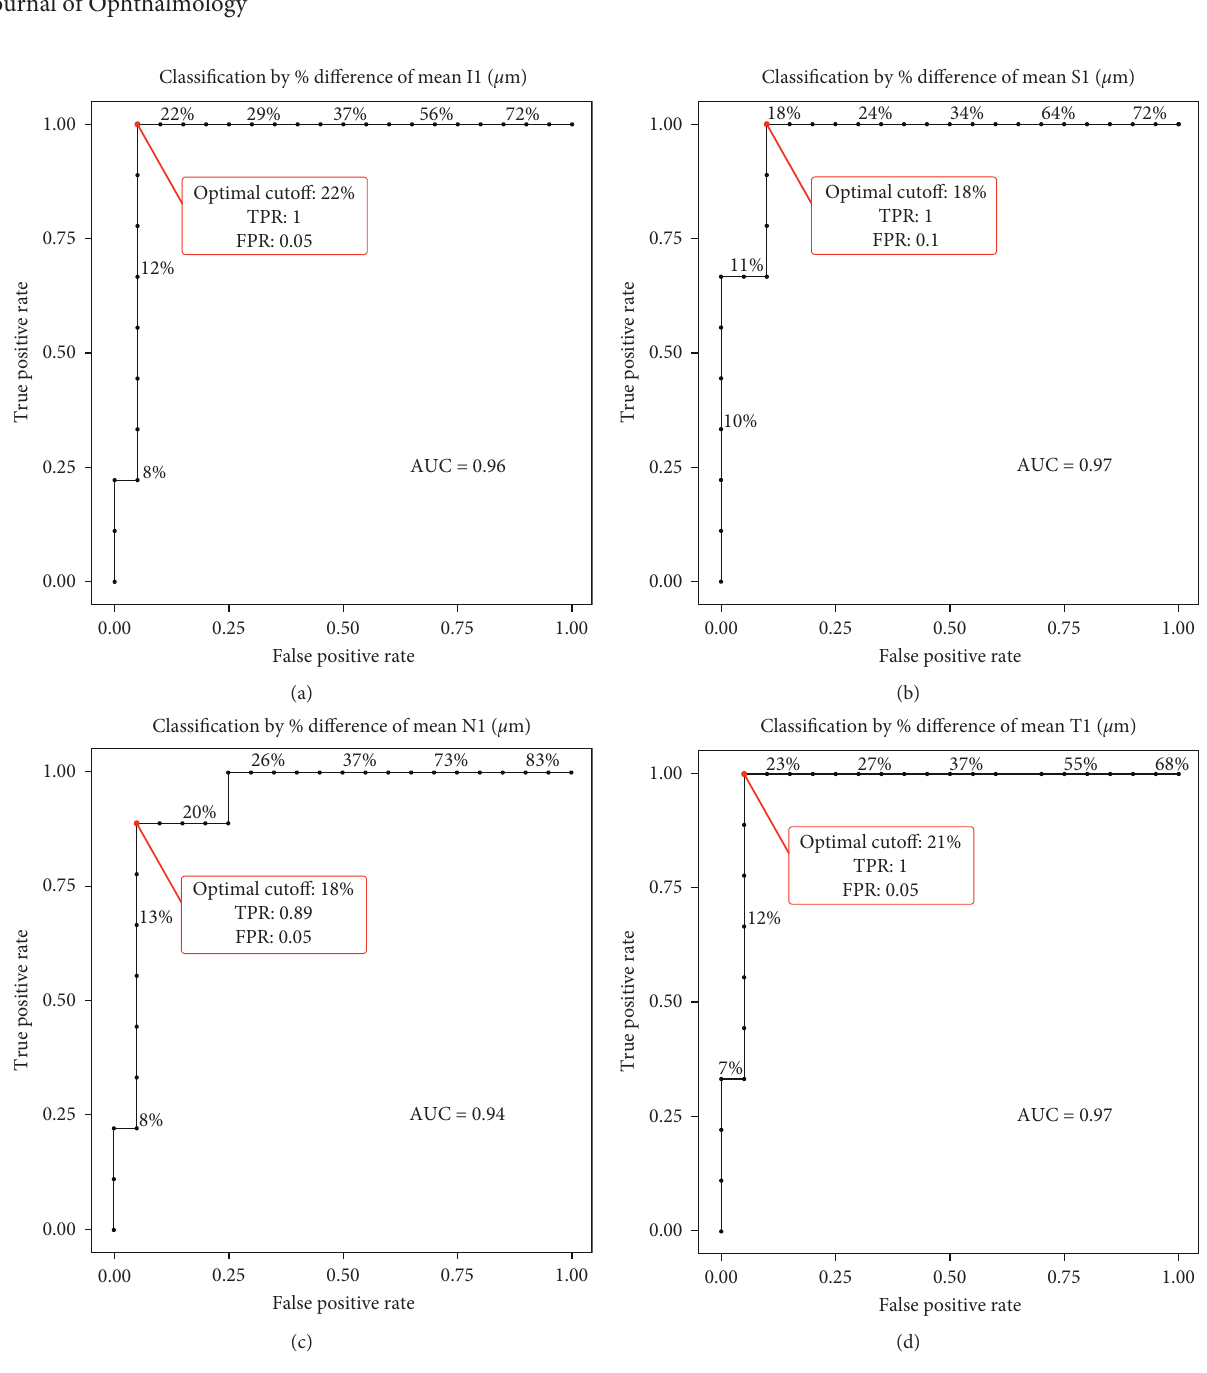
Figure 3: Receiver operating characteristic (ROC) curve analysis. Calculation of the diagnostic performance of optical coherence to- mography- (OCT-) based relative retinal thickness increase (RRTI) to distinguish between time to OCTof less and more than 4.5 hours in all 4 ETDRS sectors. The inferior sector (a), the superior sector (b), the nasal sector (c), and the temporal sector (d). On the y -axis, the true positive value represents sensitivity, while the x -axis shows false positive values from which the specificity can be calculated by 1 − false positive value. The area under the ROC curve (AUC) is given for each